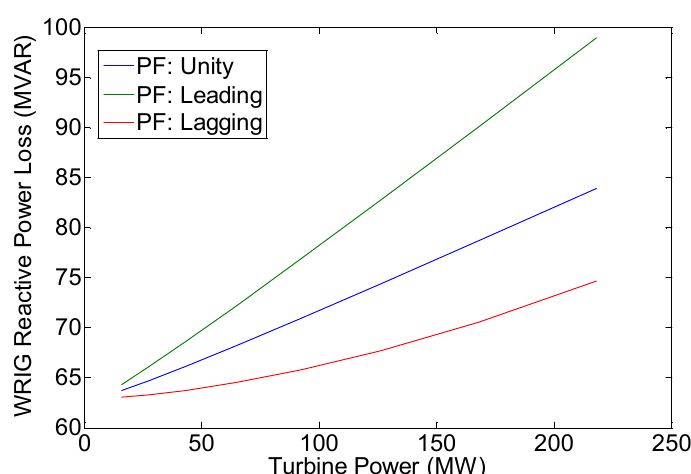
Figure 10. Variation of WRIG rotor power ( Q R ).